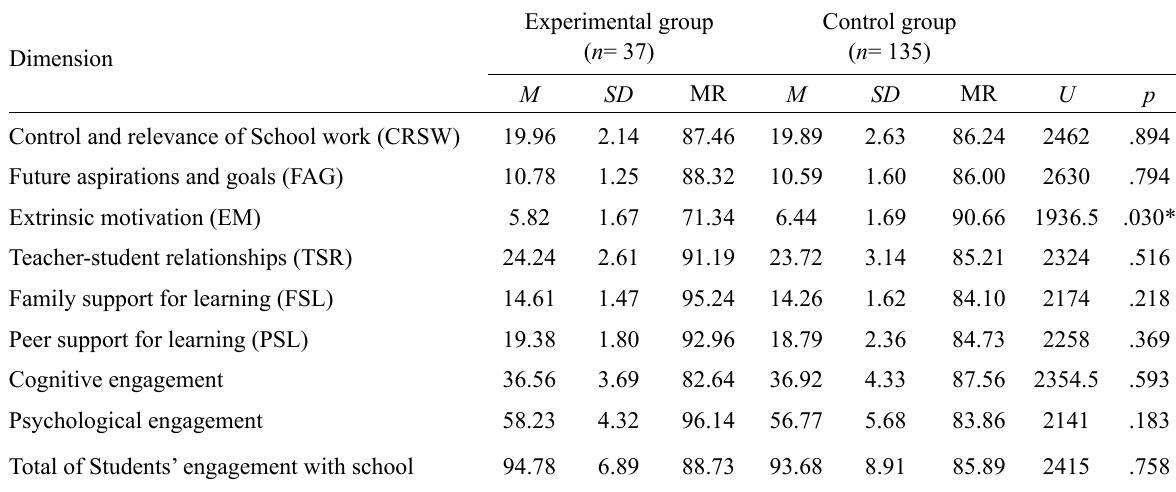
Total of Students’ engagement with school